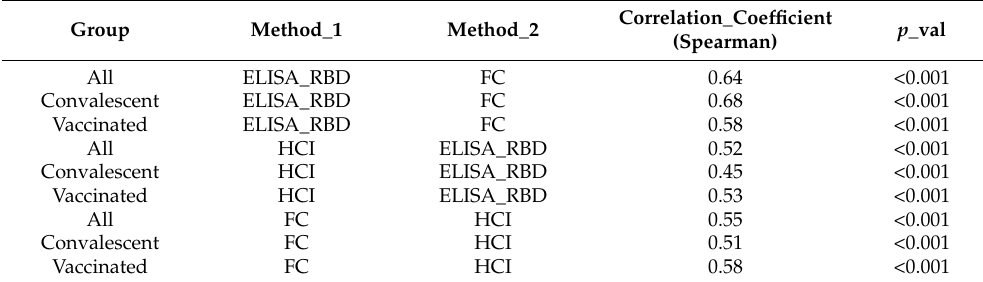
Table 2. Comparison of SARS-CoV-2-speci fi c antibody responses versus neutralisation titres, through various methods.